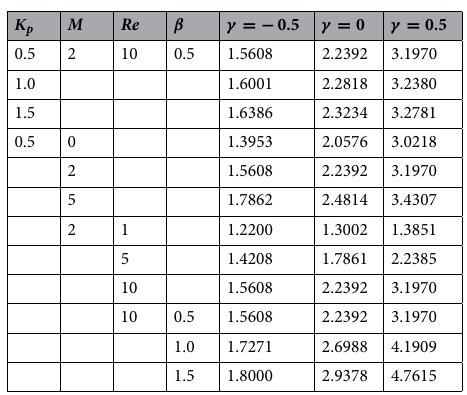
f ′′ ( 0 ) for varying K p , M , Re , and β . −